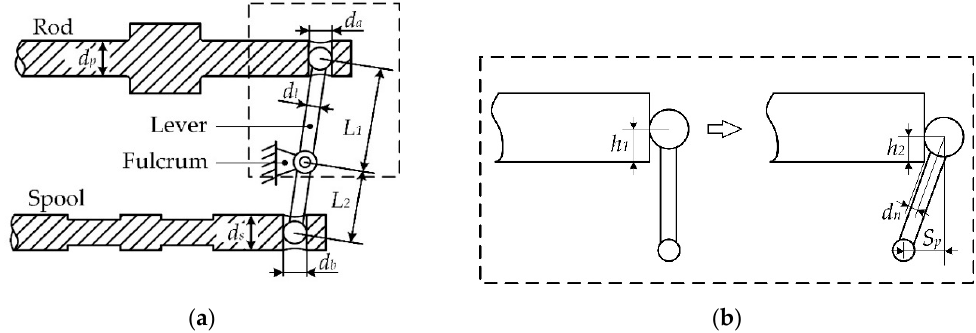
Figure 3. Schematic design of the lever: ( a ) lever between the rod and spool; ( b ) piston moves from neutral to the limit.